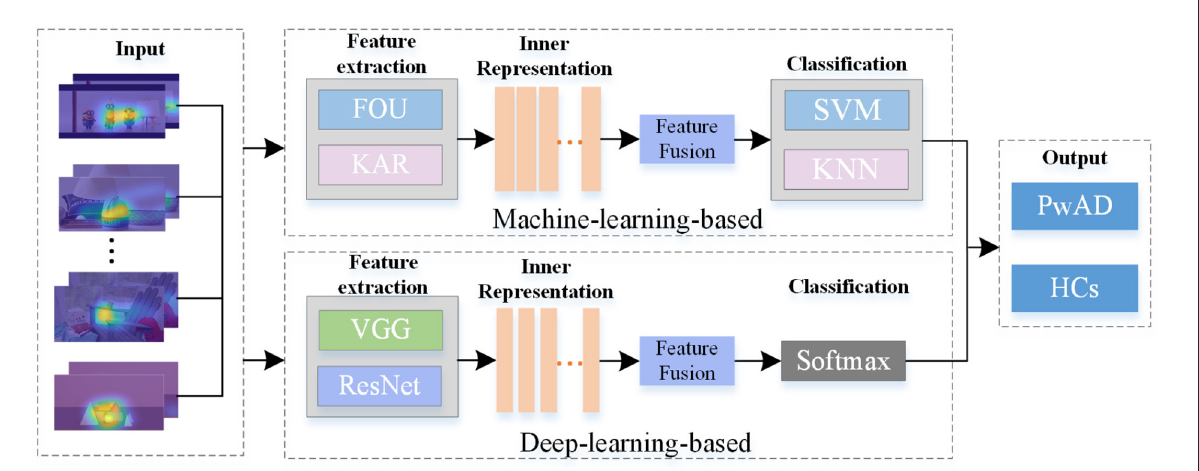
FIGURE5 The main framework of the models for comparison. For the machine-learning-based methods, we employ the FOU and KAR for feature extraction and the SVM and KNN for binary classification, respectively; And for deep-learning-based methods, we use VGG-16 network and Resnet-18 network to extract the features and use FC networks for classification.